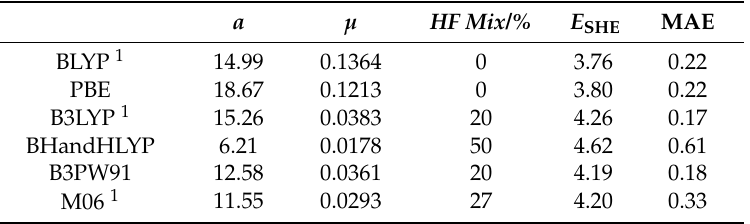
Table 2. The parameters of the pseudo counter ion solvation (PCIS) scheme and mean absolute error (MAE) by hybrid DFTs.